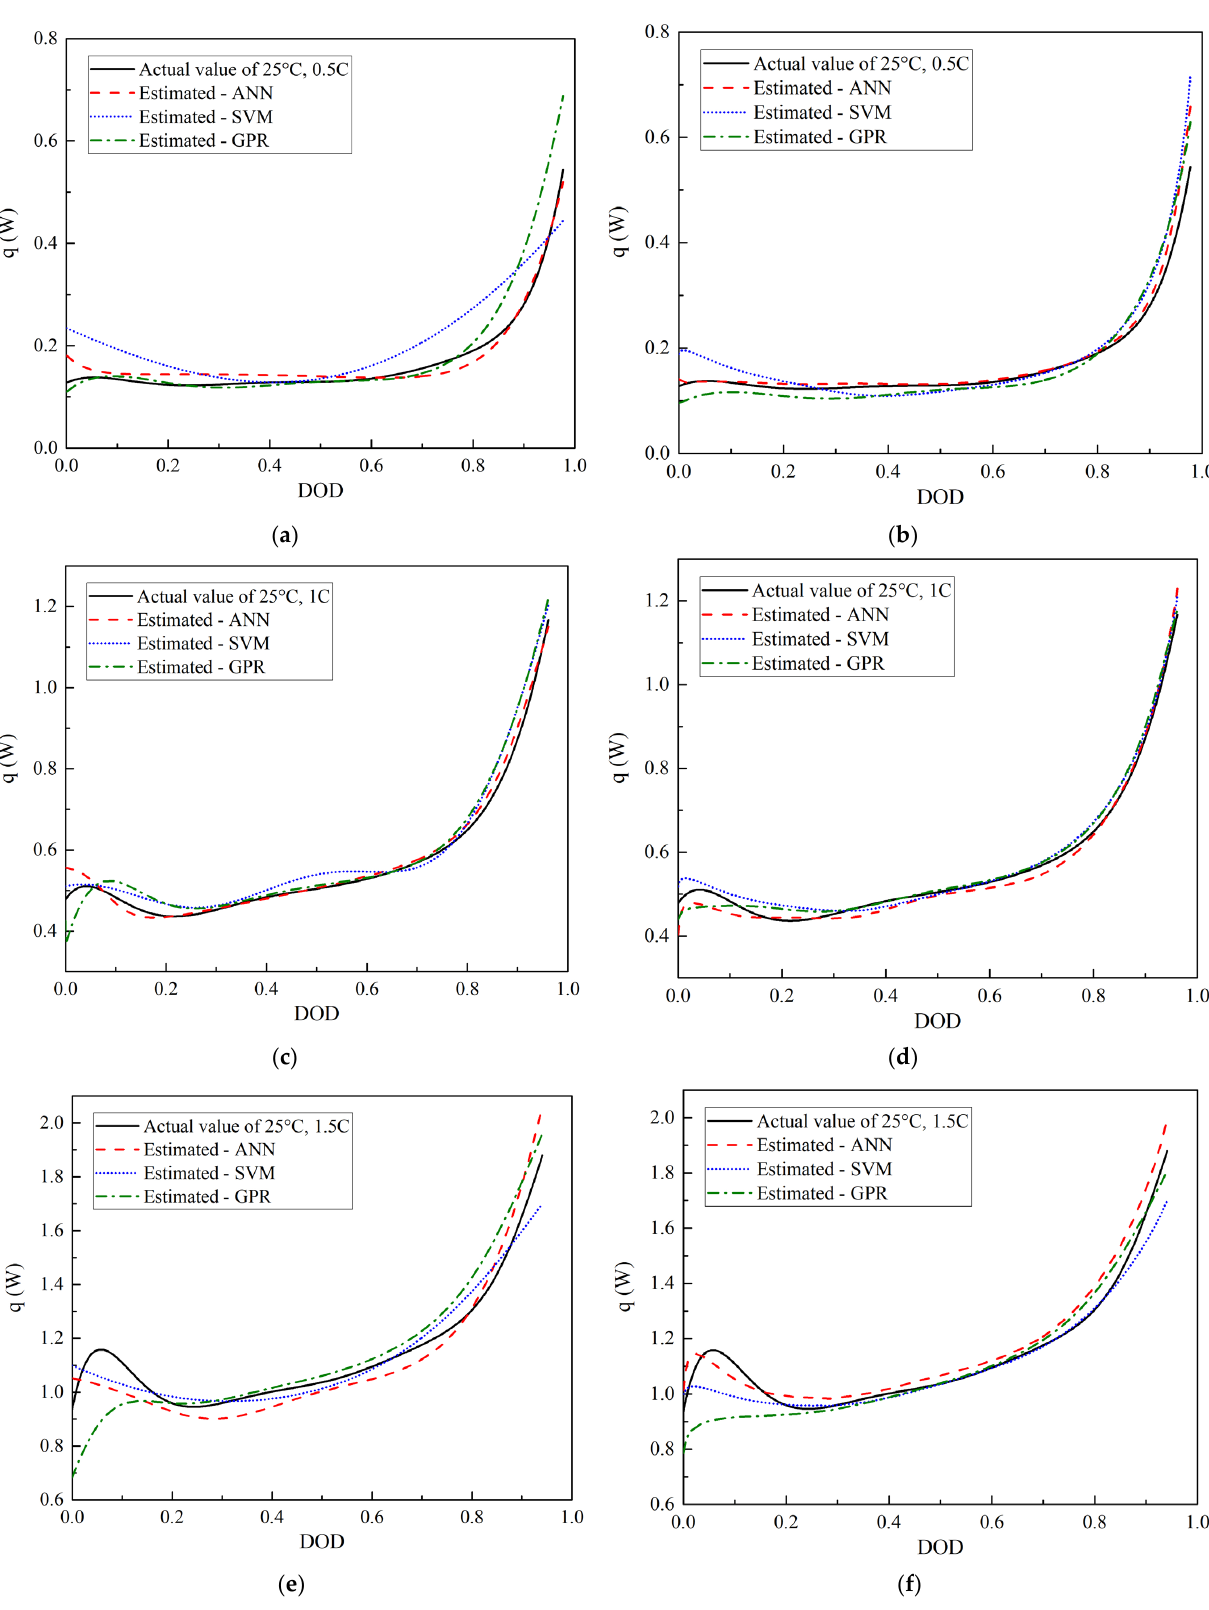
Figure 2. Comparison of the estimated and actual HGRs: ( a ) 0.5 C discharge without discharge voltage as an input; ( b ) 0.5 C discharge with discharge voltage as an input; ( c ) 1 C discharge without discharge voltage as an input; ( d ) 1 C discharge with discharge voltage as an input; ( e ) 1.5 C discharge without discharge voltage as an input; ( f ) 1.5 C discharge with discharge voltage as an input. Table 2. ANN architectures and covariance functions of GPR that were used, and R 2 of the regres- sions.